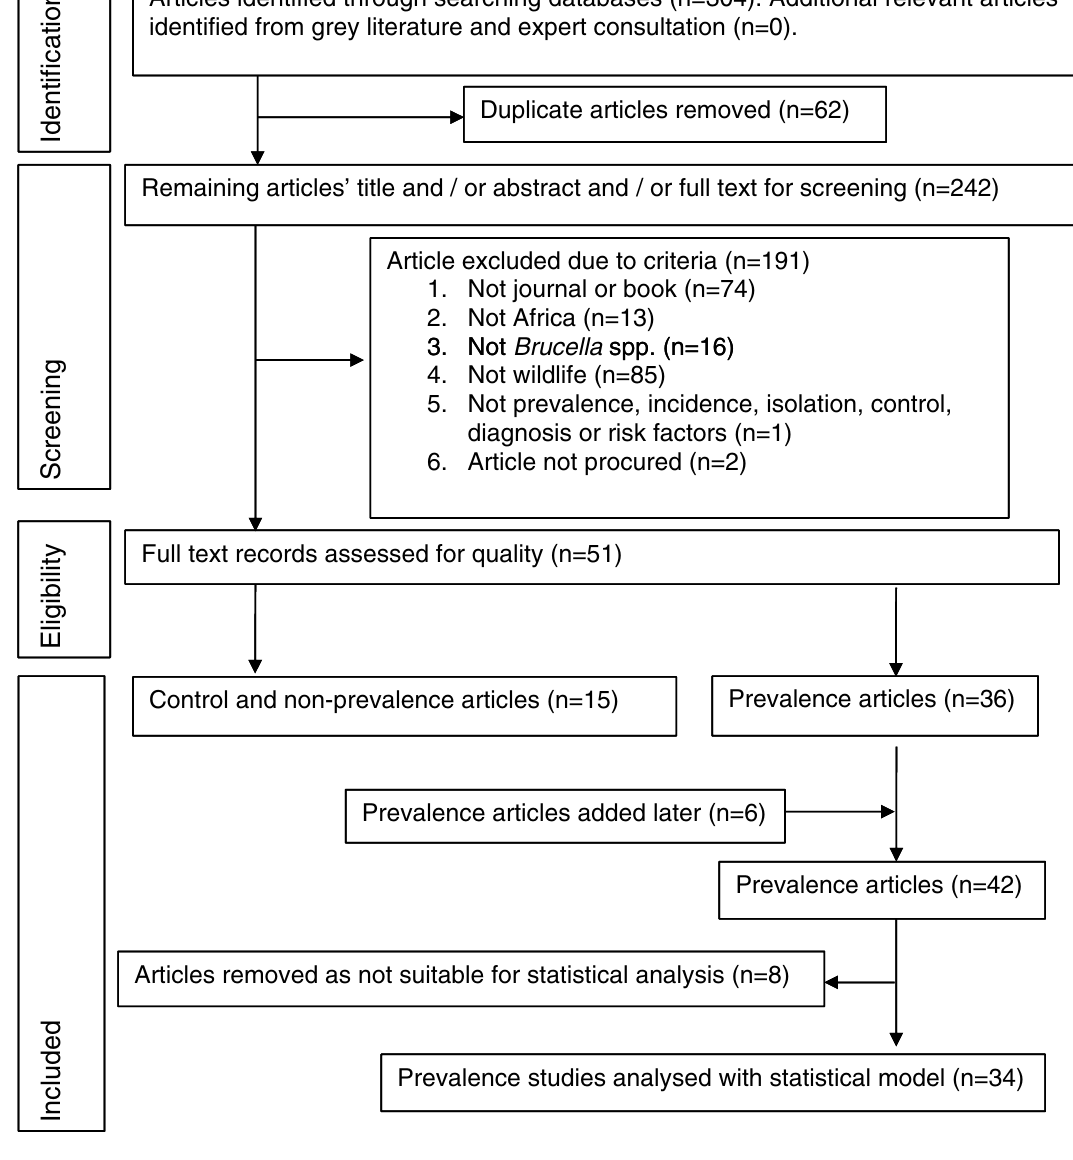
Figure 1. Flow diagram of study